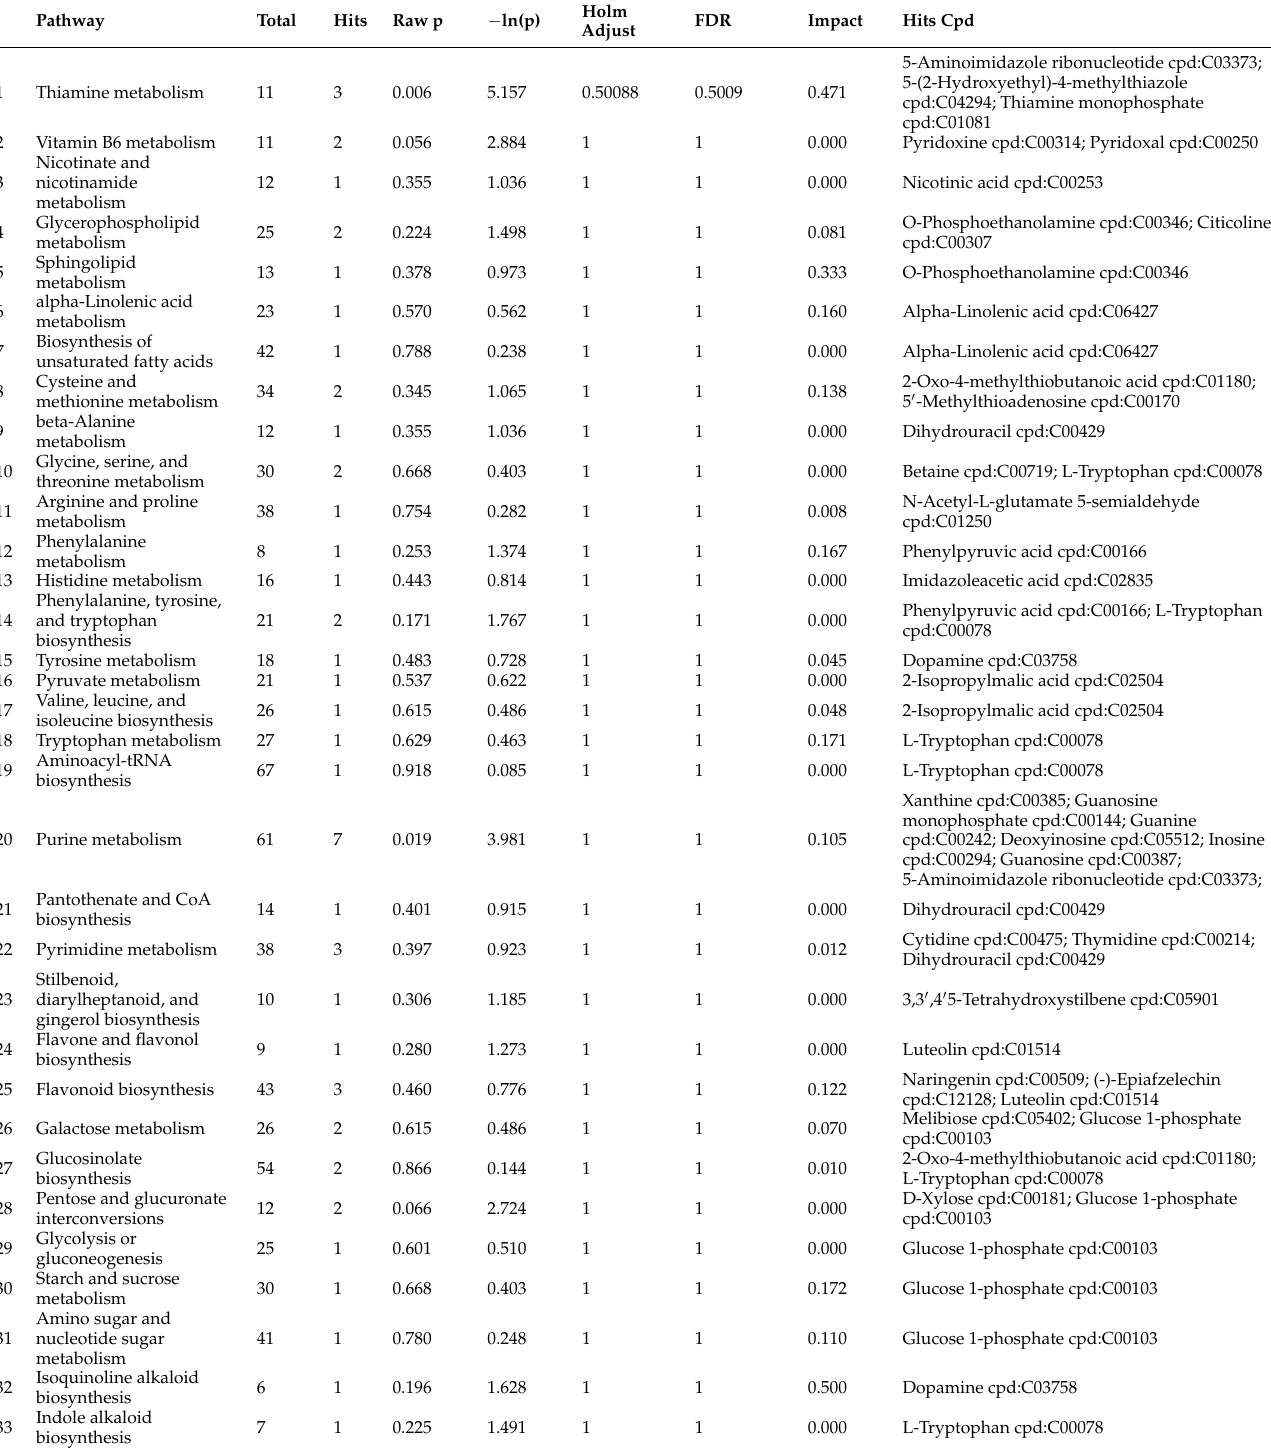
Table 3. Pathway analysis of different components of black beans following